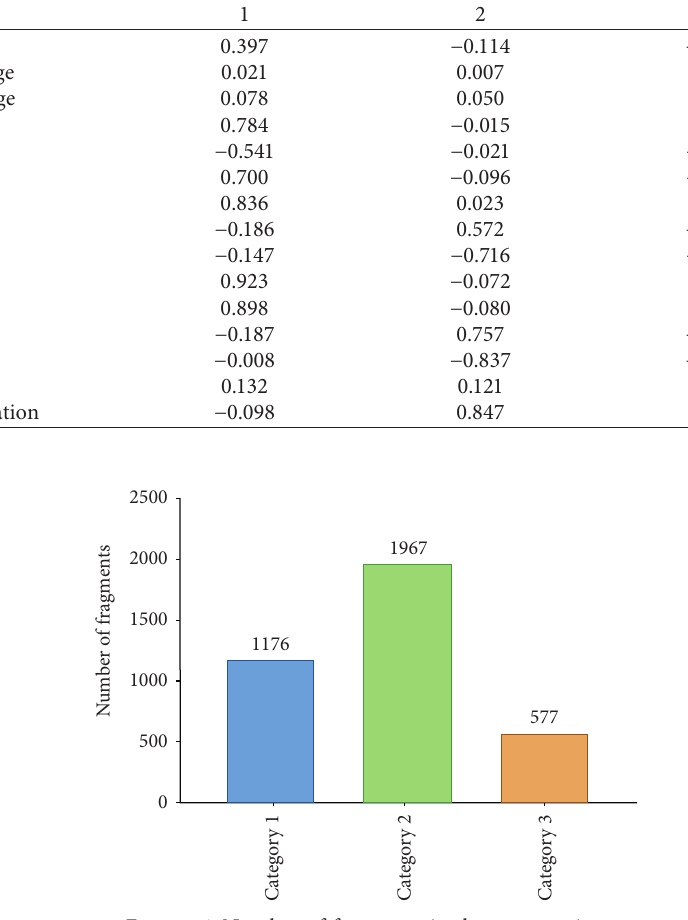
Figure 6: Number of fragments in three